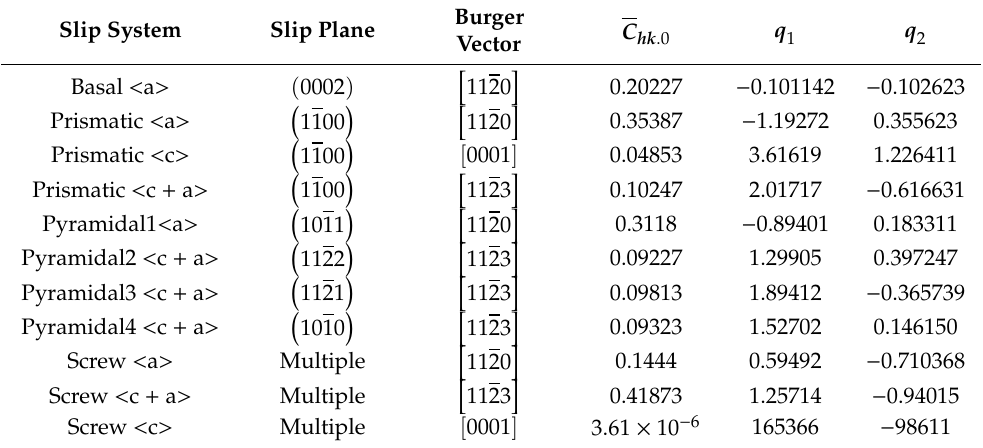
Table 3. Numerical calculated values of C hkl , q 1 and q 2 for the most common slip systems in titanium [20].